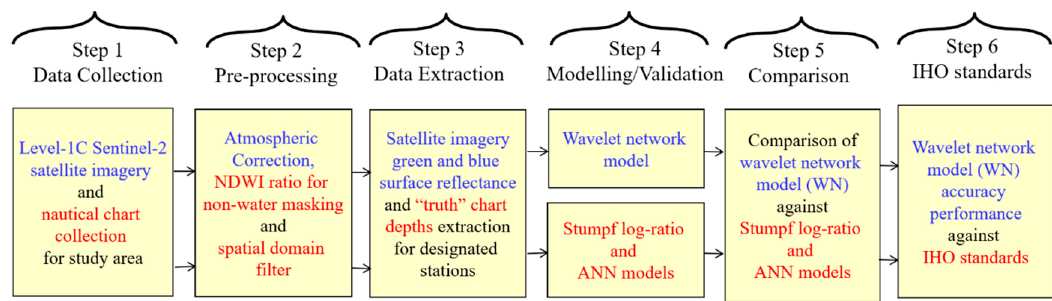
Figure 2. Research process flowchart (normalized difference water index, NDWI; artificial neural network, ANN; International Hydrographic Organization, IHO).